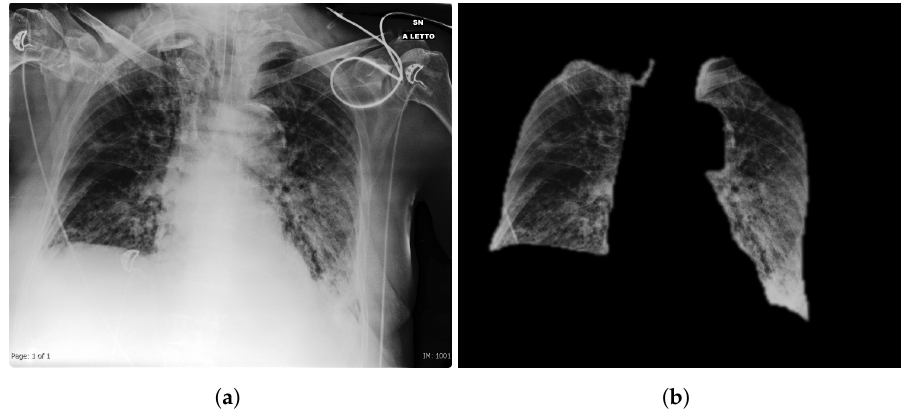
Figure 2. Original image ( a ) and extracted lung segmented image ( b ). Many possible bias sources like all the writings and medical equipment is naturally